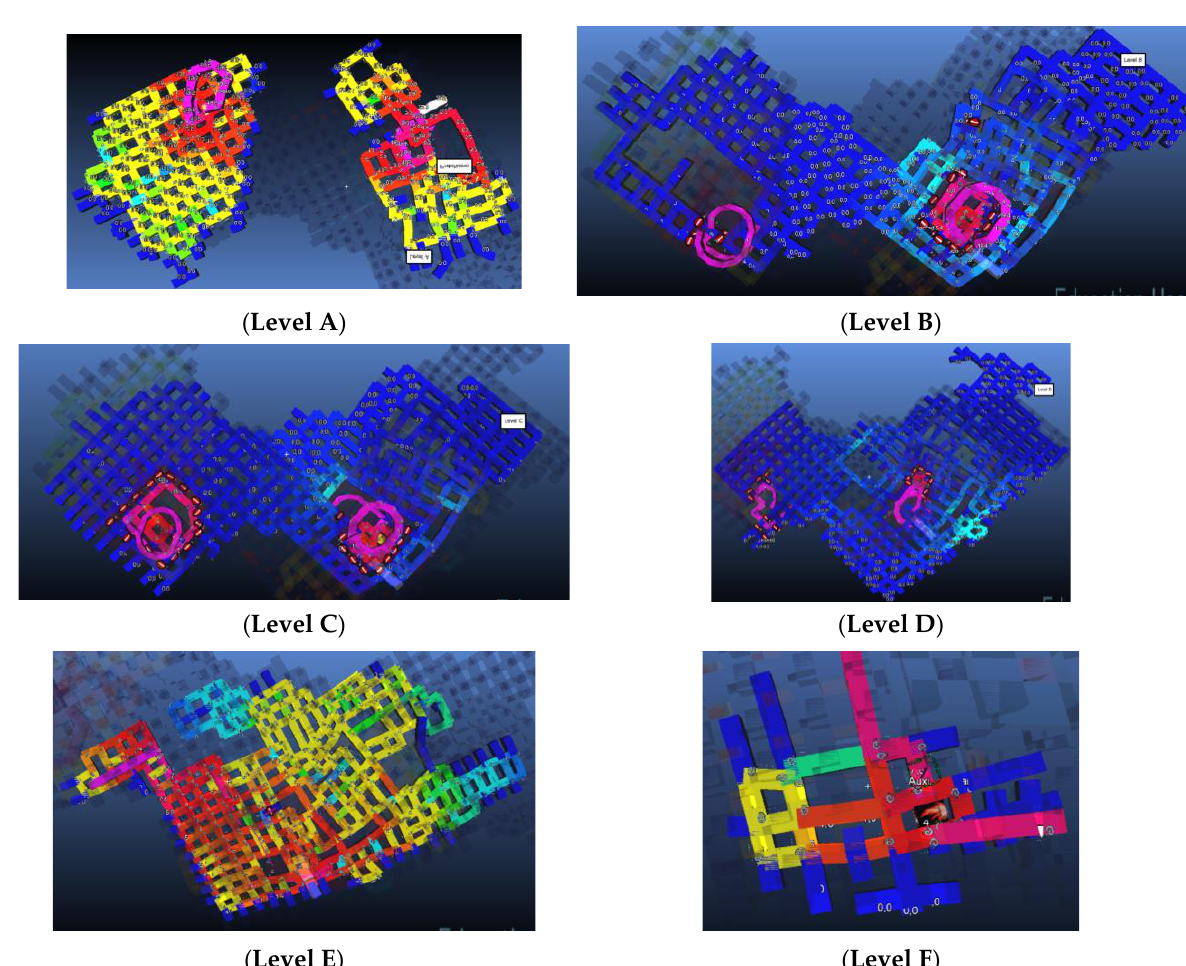
Figure 5. The plan view of each level of the mine, simulated in the 3D numerical model of the mine in order to analyze the air conditions during the fire.